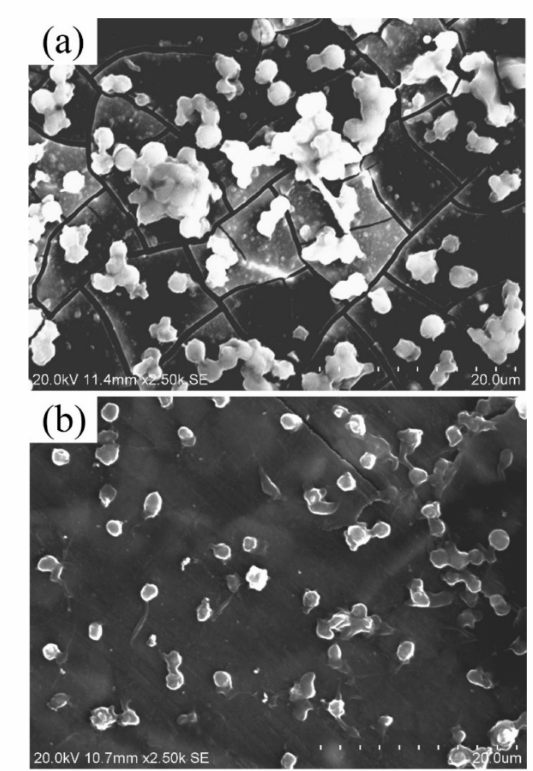
Figure5. Typicalmorphologyofadherentplateletsonsurfaceof( a )MgZnsubstrateand( b )TiO 2